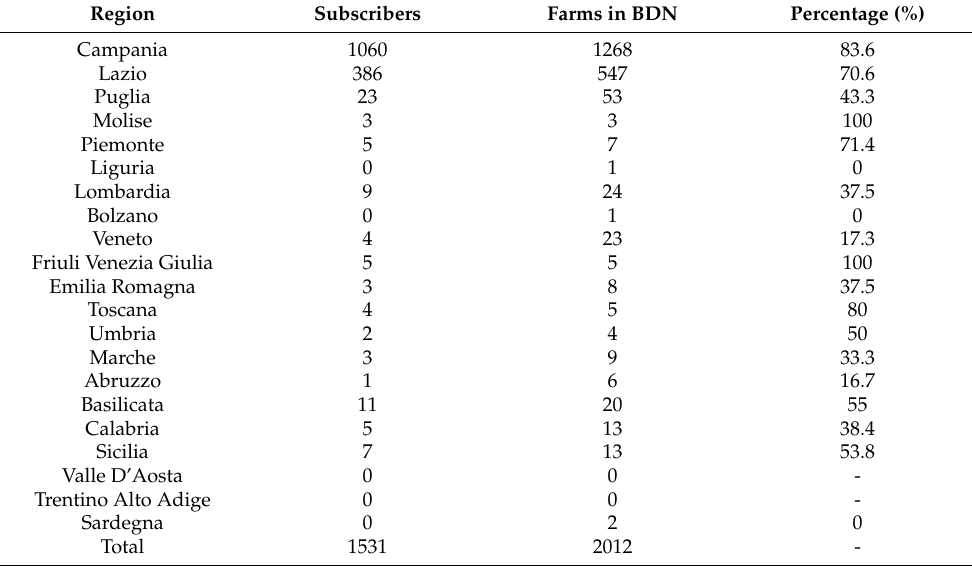
Table 1. Dairy buffalo farms registered in the traceability system in